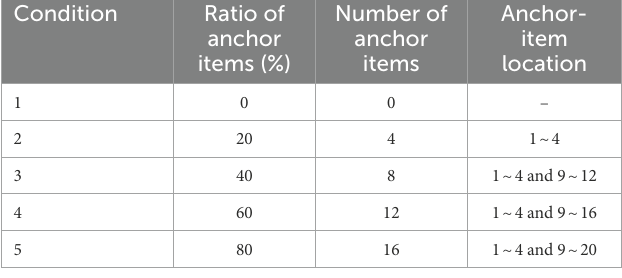
TABLE 2 Anchor-item settings for conditions with 20 items in Study 2. Condition